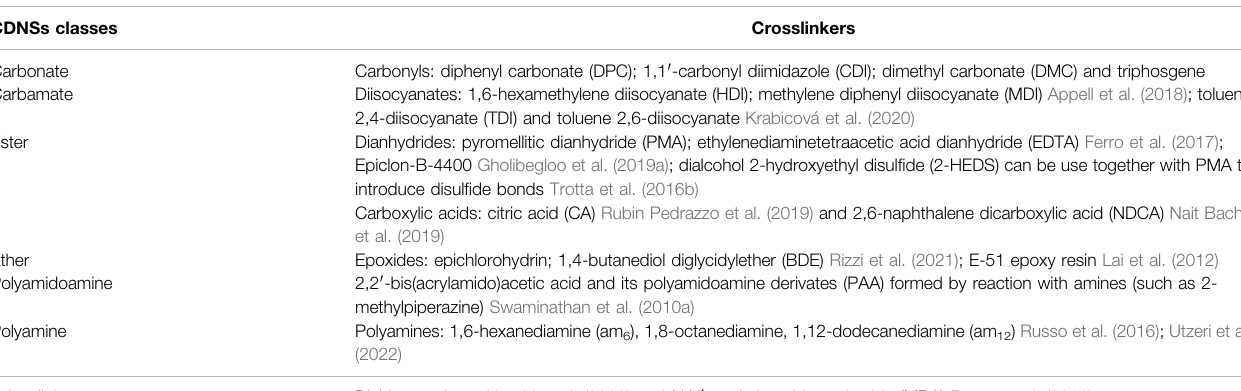
TABLE 1 | Crosslinking agents used in the preparation of different categories of